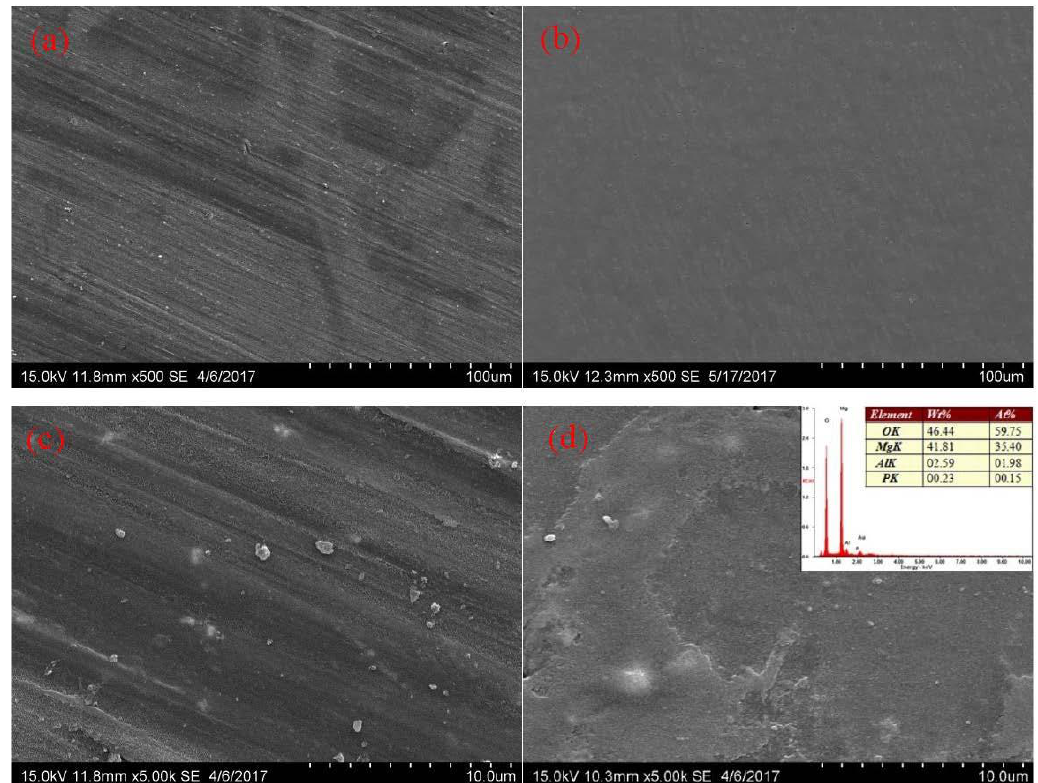
Figure 2. Representative SEM images showing surface morphologies of the AZ31B alloy pre-treated ( a , c )without, and ( b , d ) with phosphate process. Note that ( a , b ) are in low magnification, while ( c , d ) in high magnification.